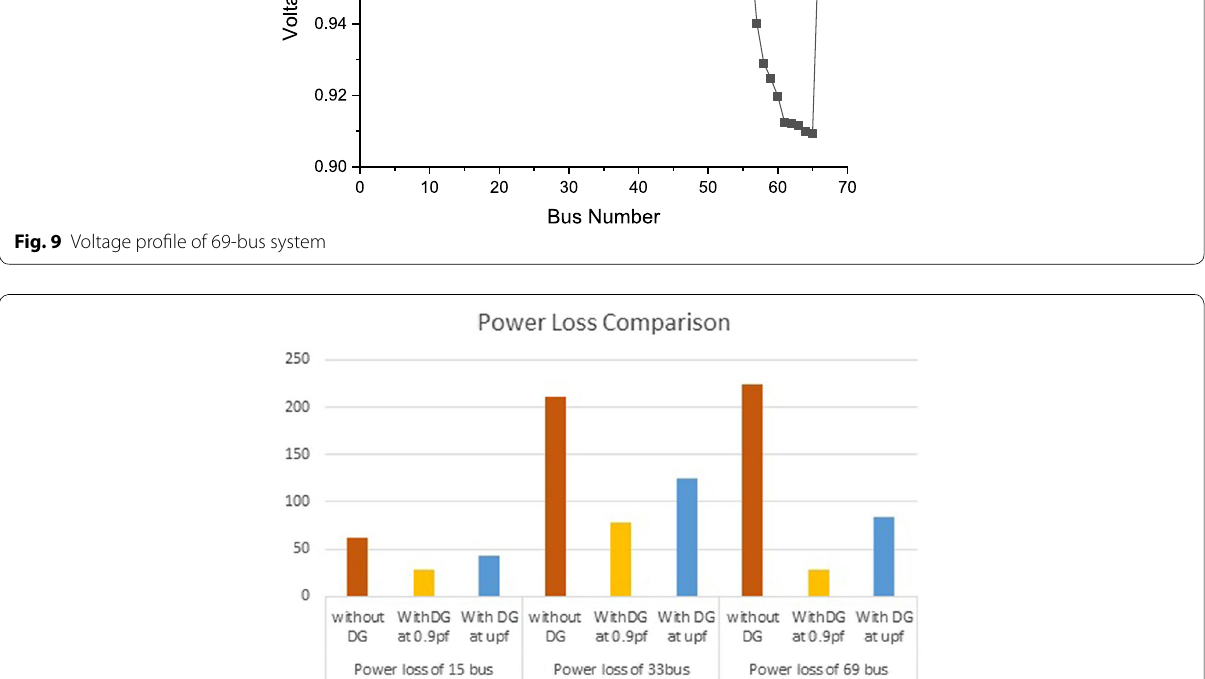
Fig. 9 Voltage profile of 69-bus system